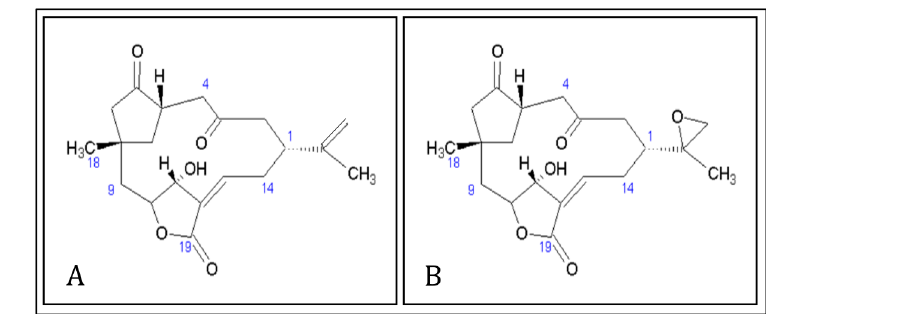
Table 1. NADPH-dependent clearance and transformation of 5ESL to 5ESLO in liver microsomes from four species of butterflyfish and recombinant human CYP3A4. Different letters indicate significant (P (cid:1) 0.05) differences between species * indicated signifcnat differences between control and pretreated C . unimaculatus (P (cid:1) 0.05) (N = 6 – 8). Species